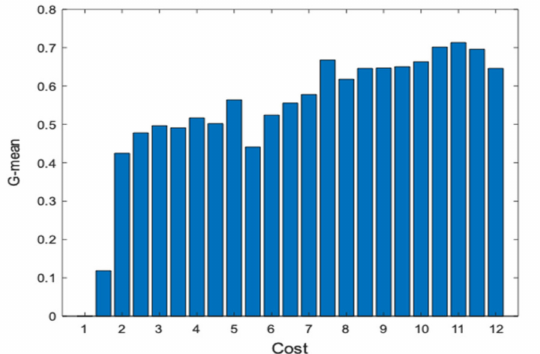
Figure 5. G-mean values vs. cost